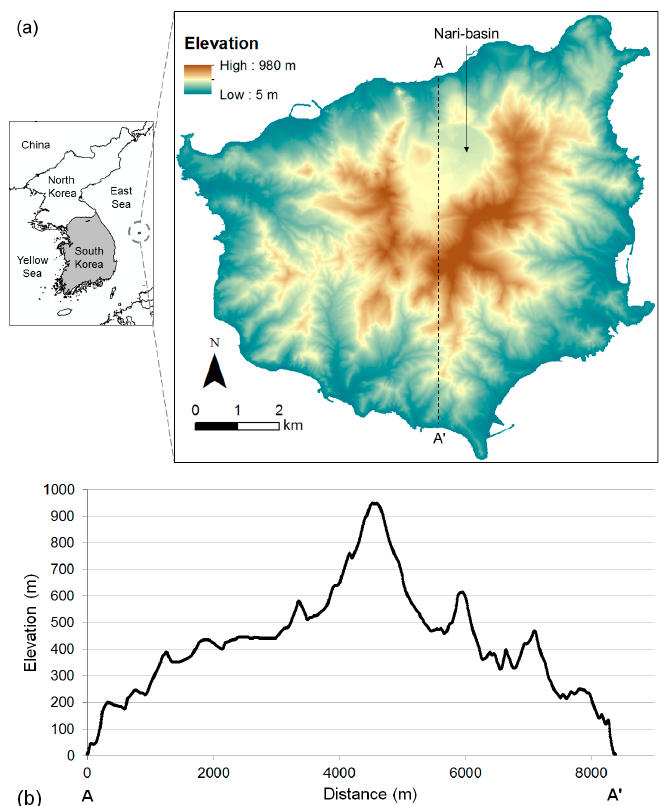
Figure 2. Study area: ( a ) geographical location and distributions of topography of Ulleung Island; and ( b ) vertical profile of A–A’ section showing very steep and complex topography ( x ‐ axis units span is approximately 5× that of the y ‐ axis).